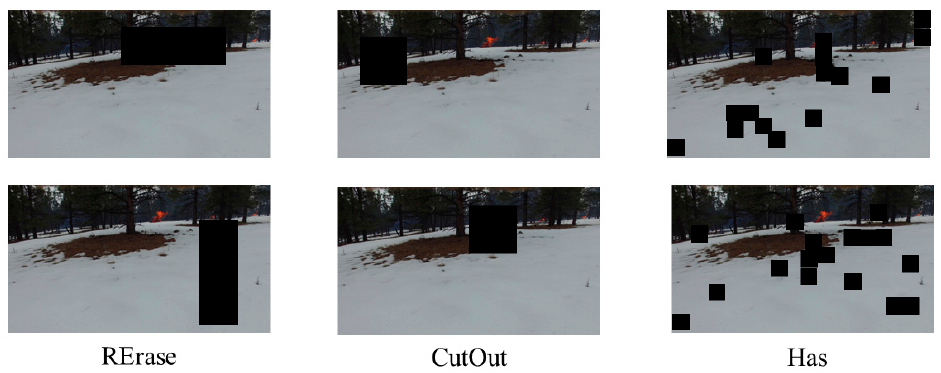
Figure 2. Images using different data augmentation techniques.